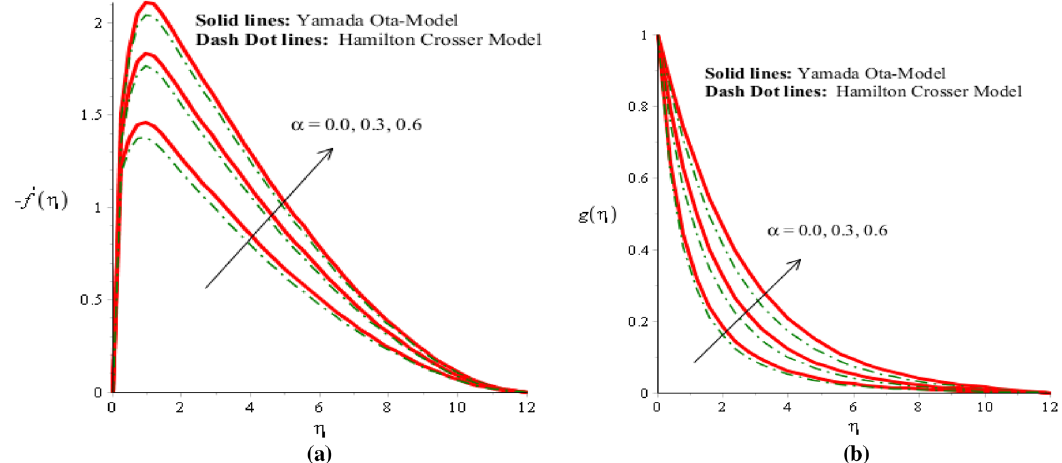
Figure 2. ( a , b ) Velocity field in y-direction and x-direction against α when ∅ 1 = 0.002, ∅ 2 = 0.0075, (cid:31) = 2.0, β e = 0.2, β i = 0.01, β = 0.3, Pr = 206, Ec = 2.2, H s = − 0.2, M = 0.03.